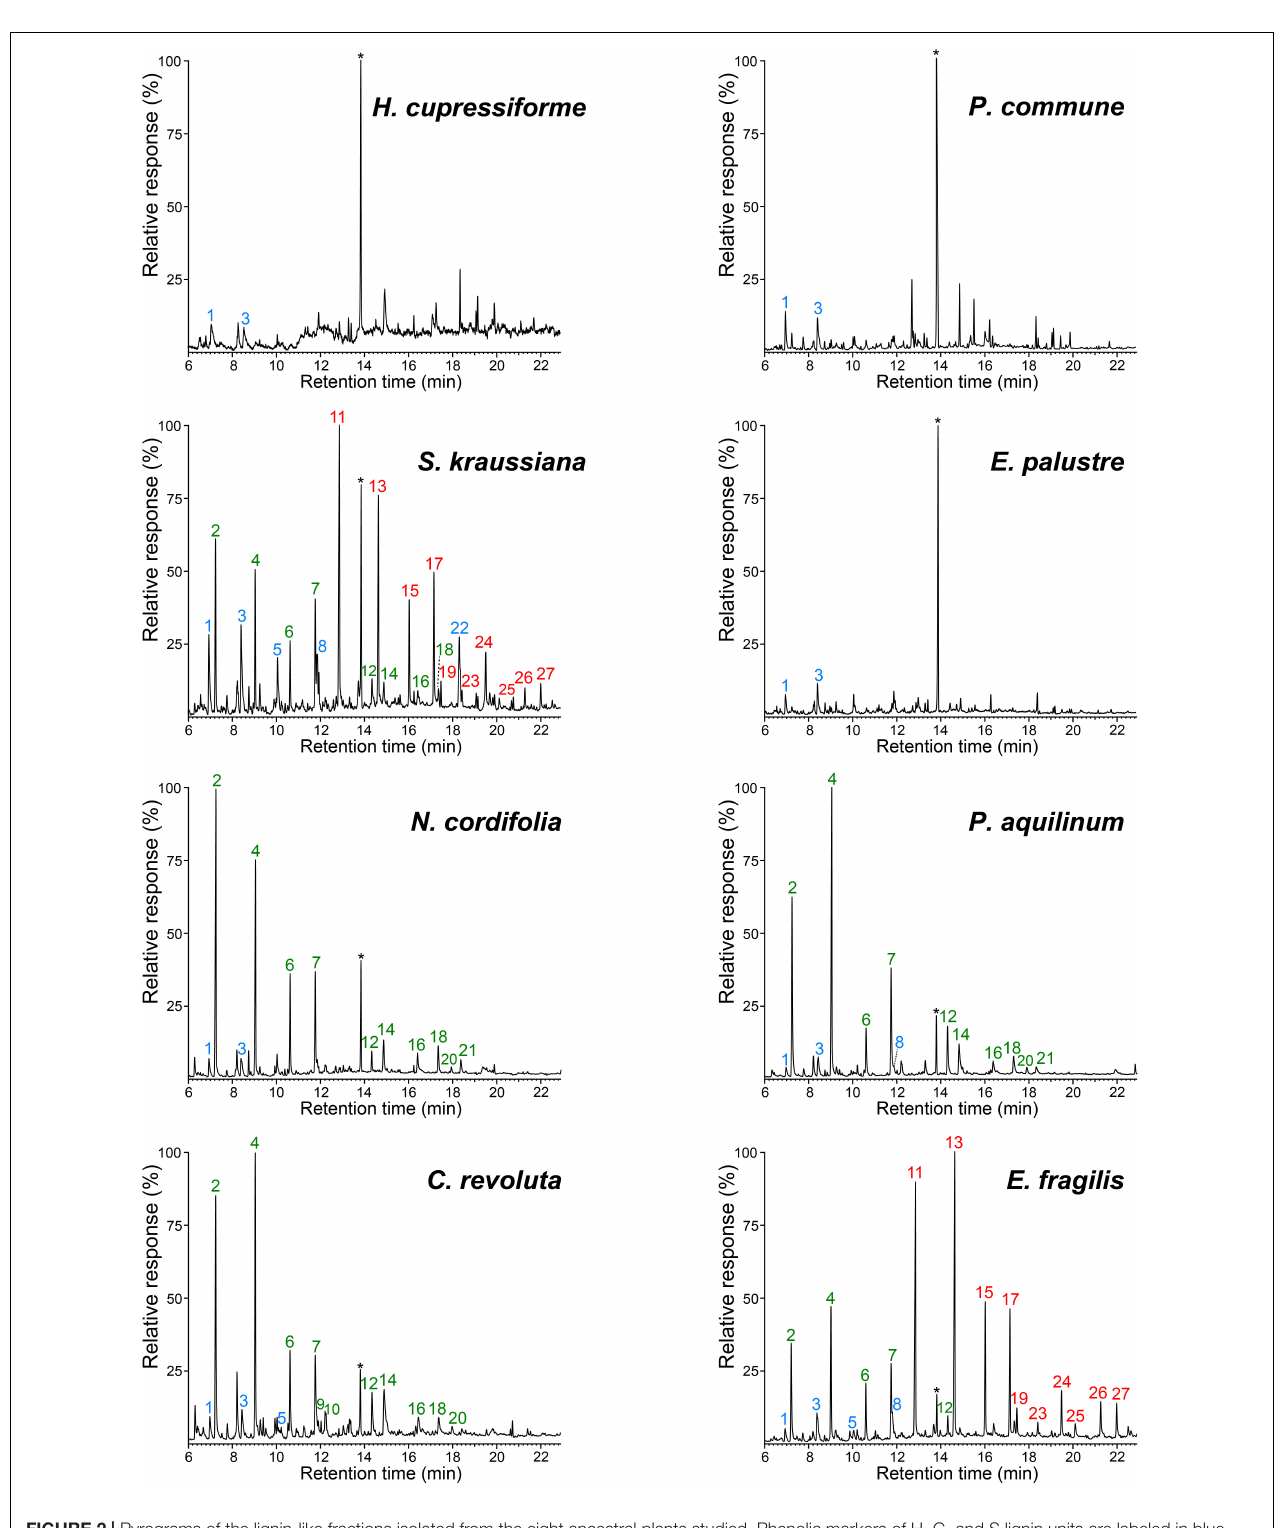
Frontiers in Plant Science |